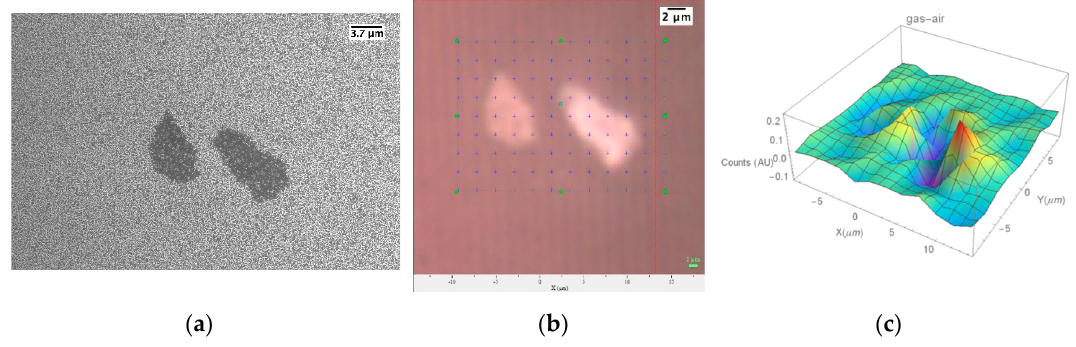
Figure 7. ( a ) SEM and ( b ) optical image of two MoS 2 +ZnO flakes whose PL response to 3ppm of NO 2 at T = 200 °C has been mapped on every reported cross ( c ) bidimensional mapping of the relative change in the exciton (UV) peak (from 380 to 410 nm) PL emission at T = 200 °C, 30% r.h., NO 2 3 ppm.